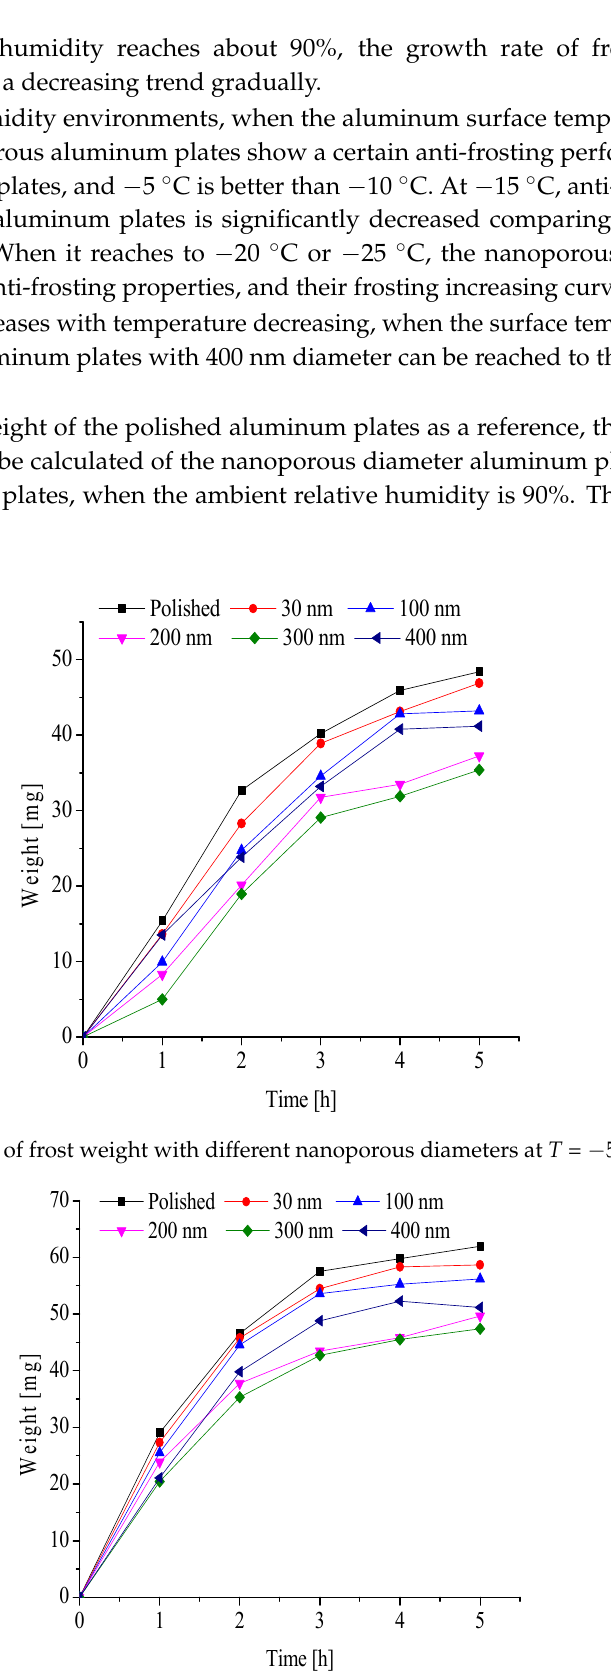
Figure 17. Variations of frost weight with different nanoporous diameters at T = − 10 °C, φ = 90%.